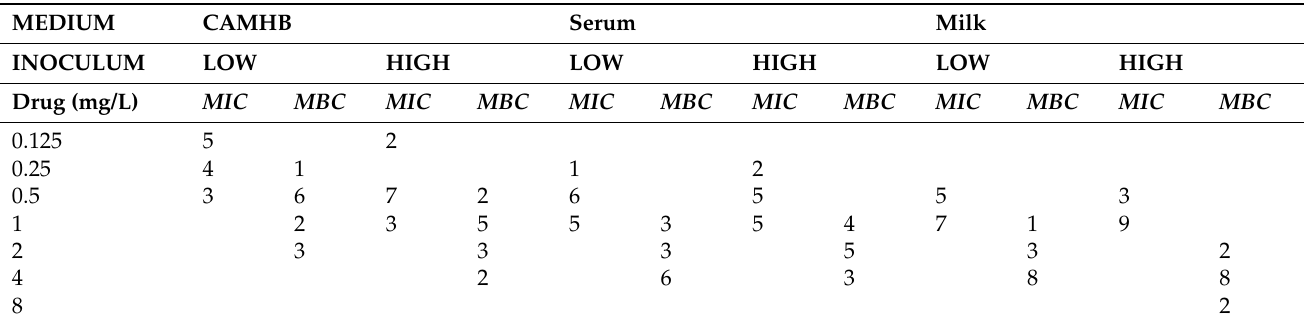
Table 1. MIC and MBC distribution values for marbofloxacin against S. aureus isolated from mastitic goats ´ milk (n = 12). Values presented for each growth medium tested for low ( ≈ 10 5 ) and high ( ≈ 10 8 ) inoculum, respectively. MEDIUM CAMHB Serum Milk INOCULUM